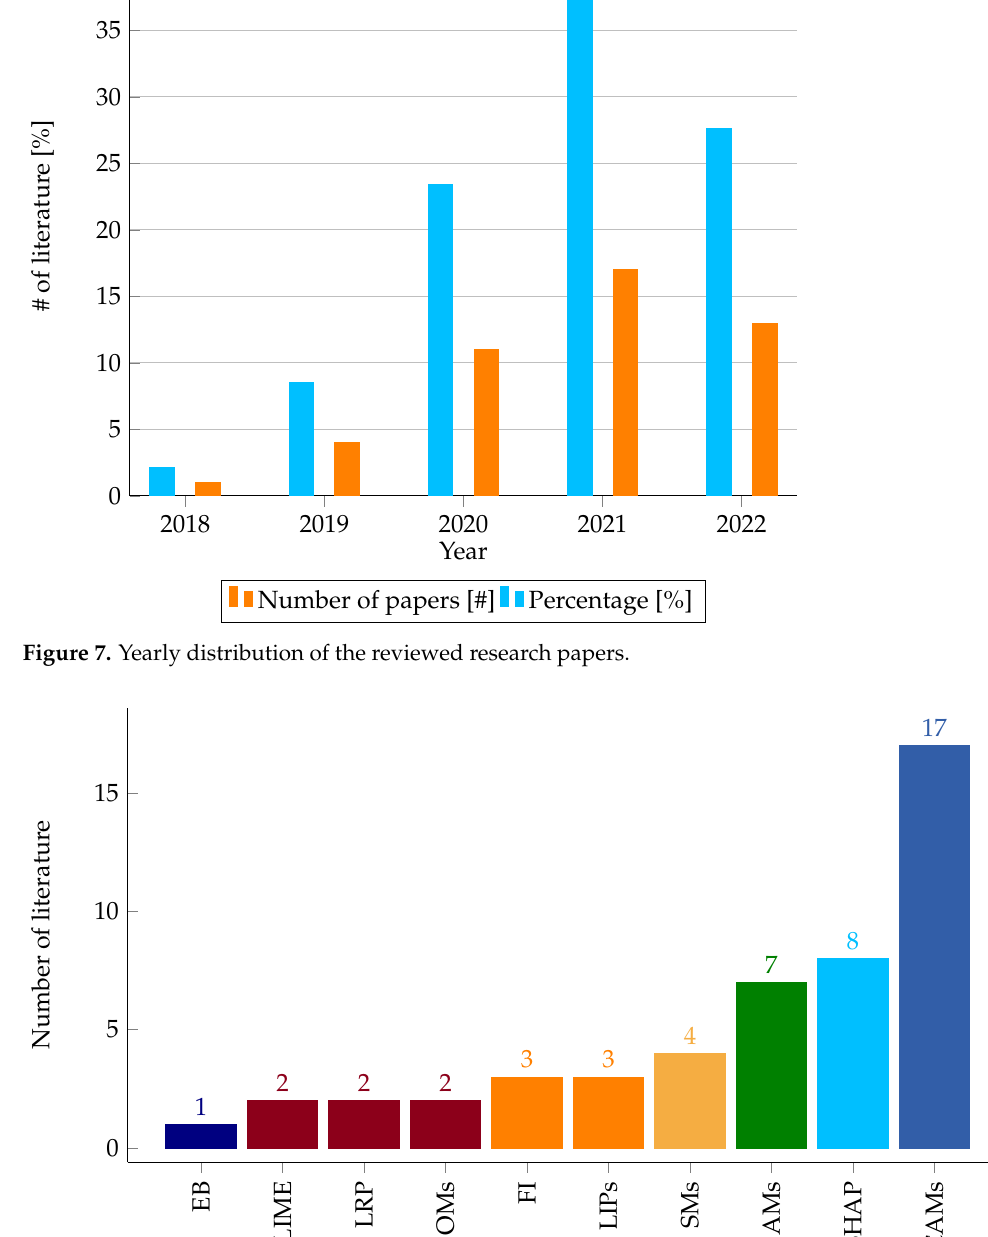
Figure 8. Type and number of reviewed IML